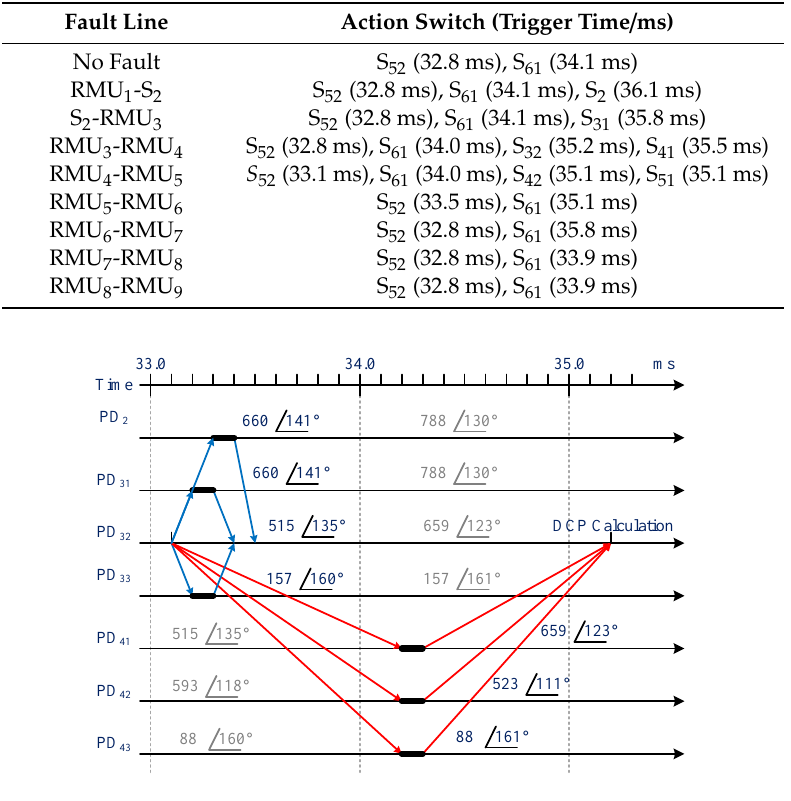
Table 4. Results of di ff erent communication line faults.